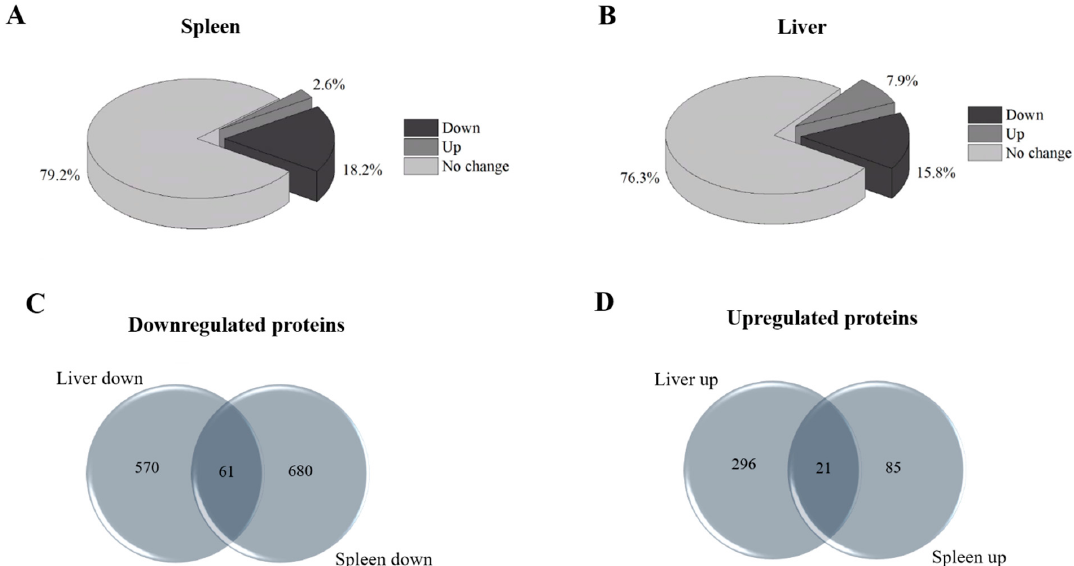
Figure 1. Comparative analysis of the differential proteome of the spleen and liver of 11-week Npc1 − / − mice. Differential proteins from the mass spectrometry analysis of the spleen ( A ) and liver ( B ) of Npc1 − / − mice where analyzed for downregulated and upregulated proteins. Evaluation of the proteome of the spleen revealed that 18.6% of the measured proteome was found to be downregulated while 2.6% was upregulated. The differential proteome of the liver was evaluated and revealed that 15.8% of the measured proteome was found to be downregulated while 7.9% was upregulated. Venn diagram analysis of the downregulated ( C ) and upregulated ( D ) proteins was performed to determine common altered proteins.